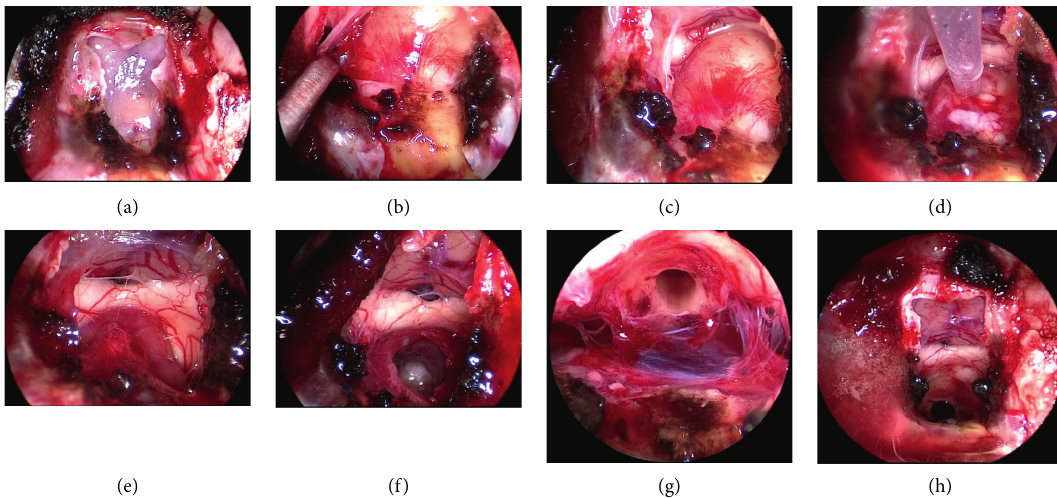
Figure 2: The intercavernous sinus has been cut after cauterization (a). A Y-shaped dural incision is made (a). The cyst wall is found above the pituitary gland (b). Vascular streaks are found on the cyst wall, indicating the pituitary stalk is tumorized (b). The cyst is displacing the optic chiasm (c). The cyst contents are aspirated via a long needle (d). After the aspiration (d), the cyst is shrunken so that the working space in this tumor resection is secured. An indentation is observed in the inferior surface of the decompressed optic chiasm (e). The solid cyst contents appeared as tissue debris, keratin, solid cholesterol, and their mixtures, which were meticulously removed (f). Since the cyst wall is the tumorized pituitary stalk, the cyst was gross-totally removed from the intrasellar part to the infundibular part (g). The opened skull base (h) is reconstructed with a fat-on-fascia graft plug